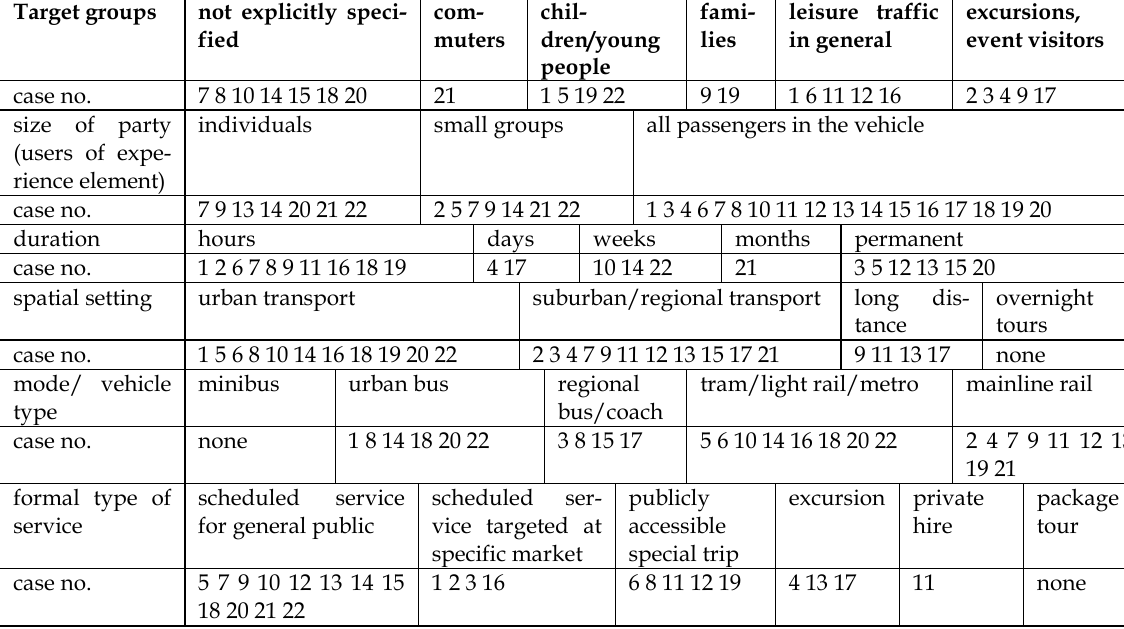
com- chil- fami- leisure traffic excursions, muters dren/young lies in general event visitors people